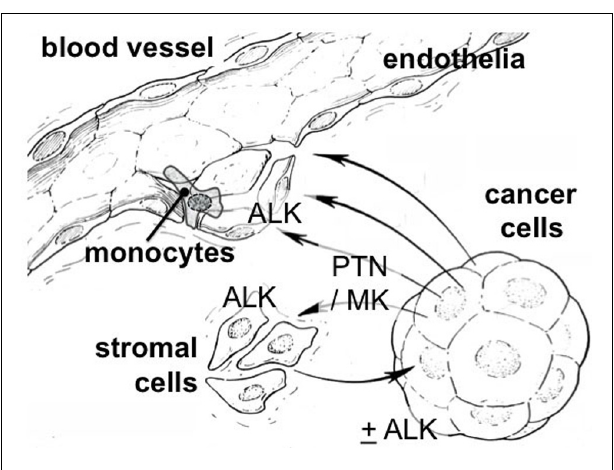
FIGURE 2 | Binding of PTN and MK to theALK receptor in intact cells. (A) Competition for ALK binding of 35 S-PTN in 32D/ALK cells. Competitors were: anti-PTN antibody, anti-ECD antibody, ECD protein, unlabeled PTN. (B) Titration of equilibrium binding of 35 S-PTN to 32D/ALK and to 32D/control cells. A Scatchard analysis of specific binding